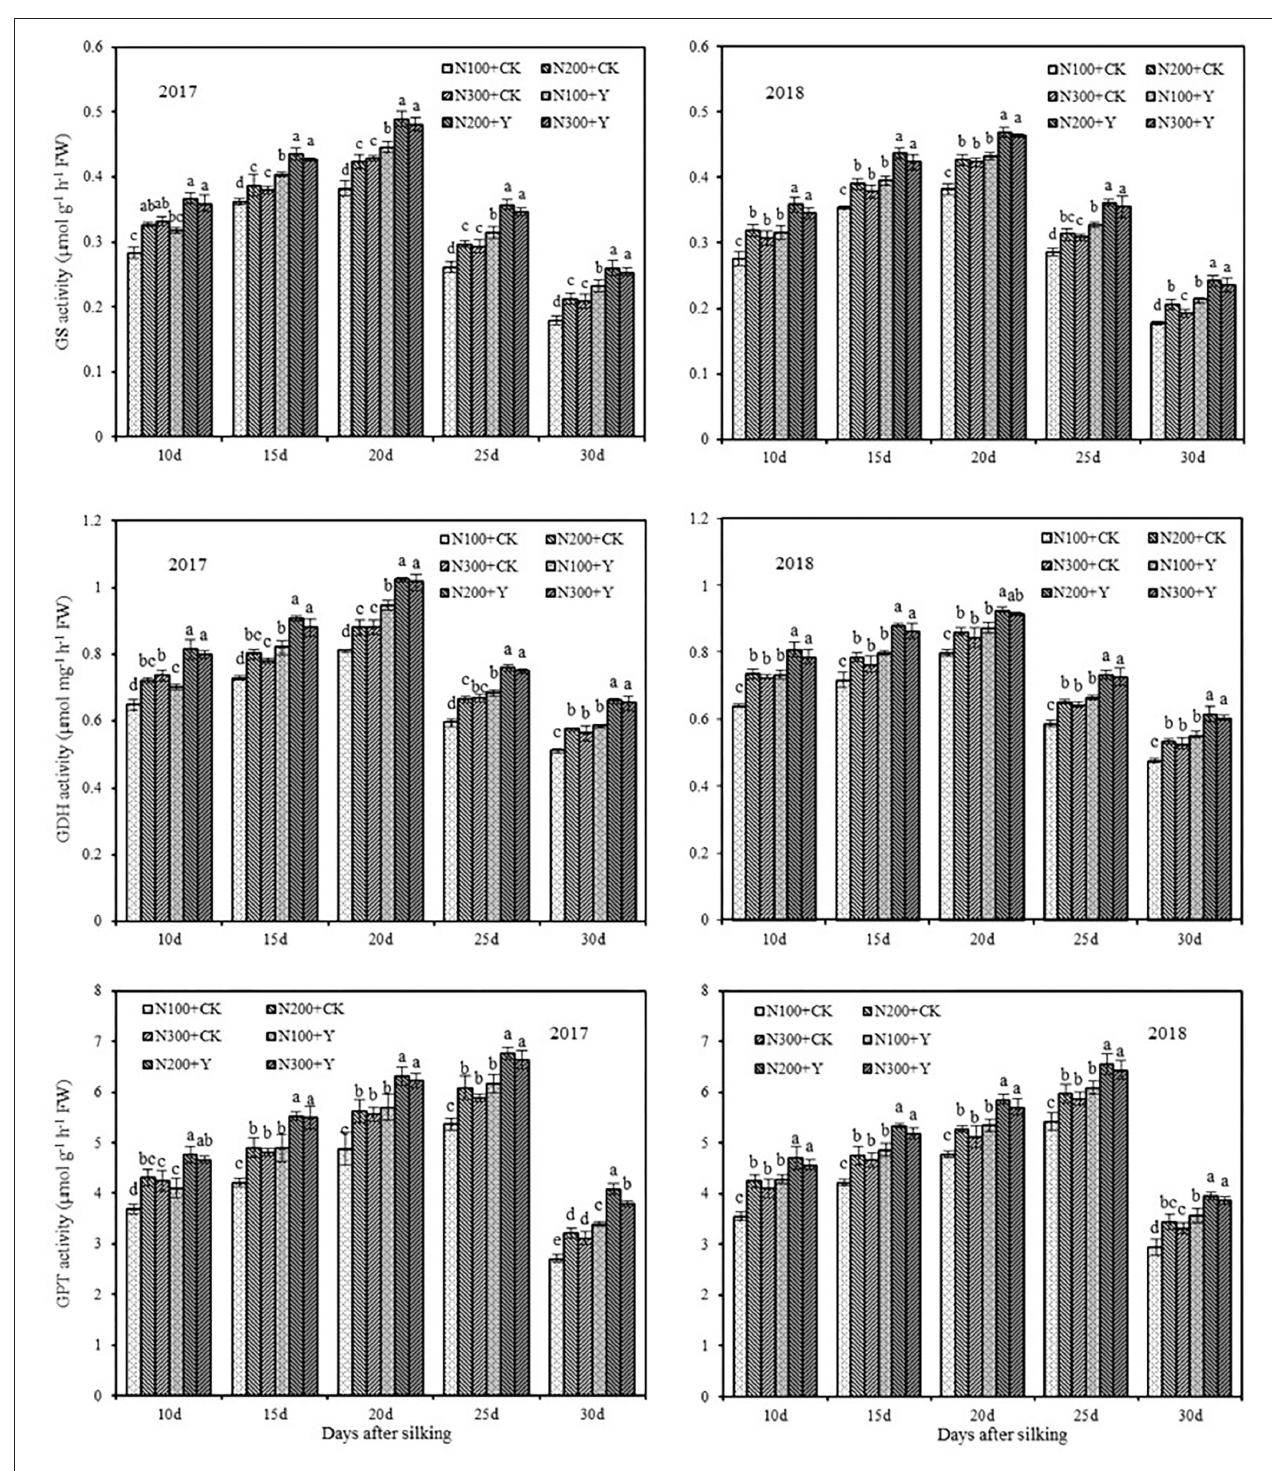
FIGURE 4 | Effects of chemical control and nitrogen fertilizers on GS, GDH, and GPT activities in grain from 10 to 30 days after silking in 2017 and 2018. N100 + CK, N200 + CK, and N300 + CK indicate nitrogen applied levels at 100, 200, and 300kg ha − 1 under water treatment, respectively; N100 + Y, N200 + Y, and N300 + Y indicate nitrogen applied levels at 100, 200, and 300kg ha − 1 under chemical control, respectively. Error bars indicate the value of standard error. Different letters within a growth stage indicate a significant difference at P < 0.05.